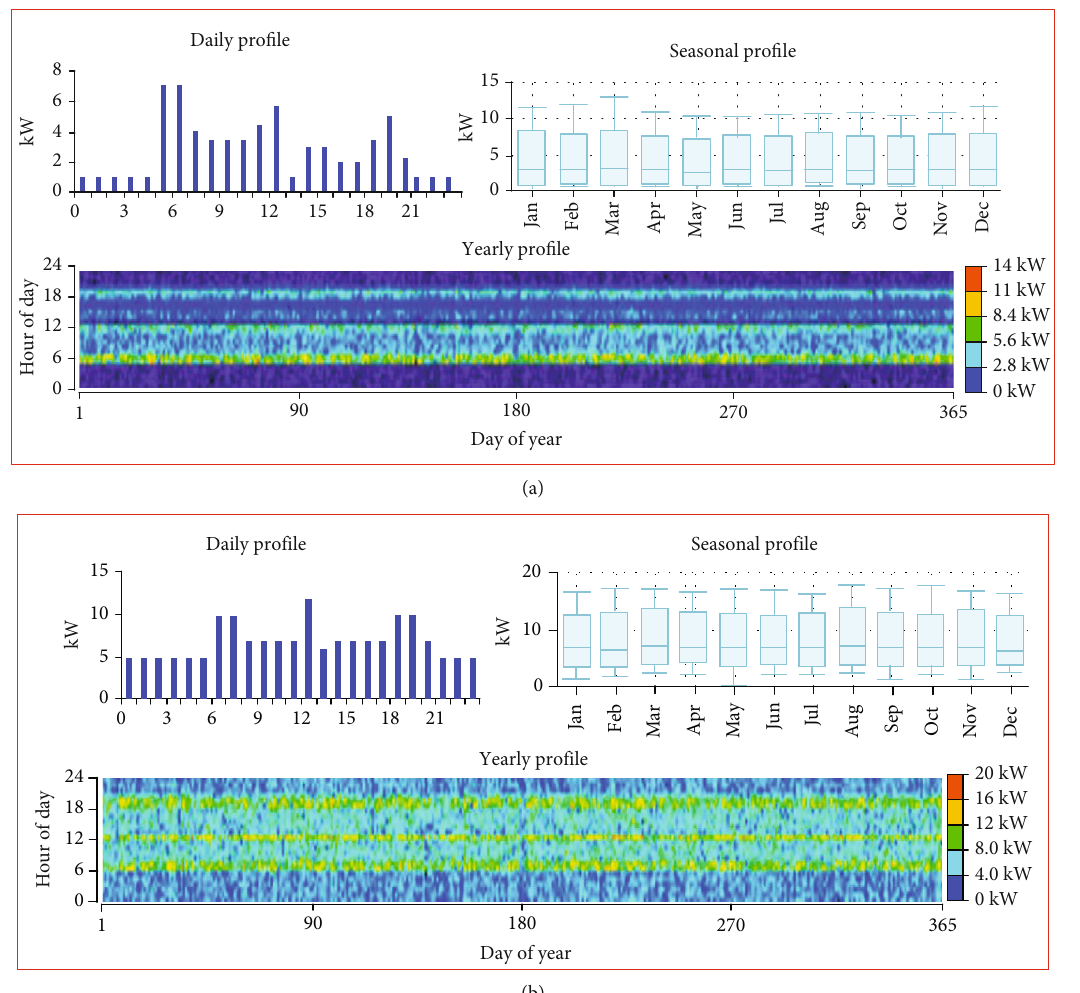
Figure 5: The daily, seasonal, and yearly load pro fi les: (a) electric load for the distinct o ff -grid household and (b) electric load for microgrids for a rural community in an o ff -grid